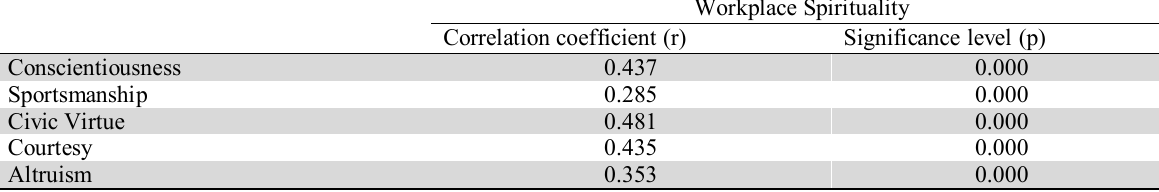
The results of correlations between workplace Spirituality and OCB Dimensions Workplace Spirituality Correlation coefficient